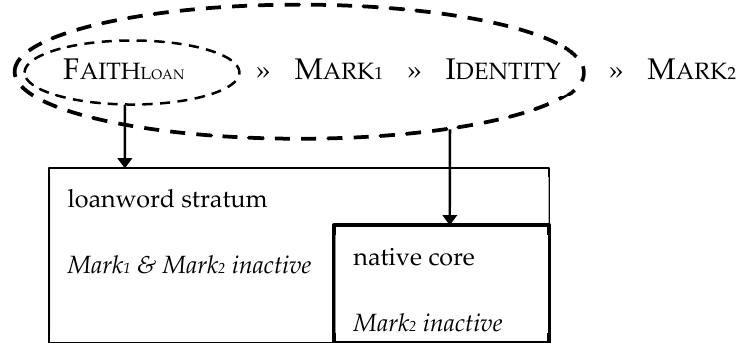
Figure 3. A core-periphery model of the Istanbul JS lexicon. Figure 3. A core‑periphery model of the Istanbul JS